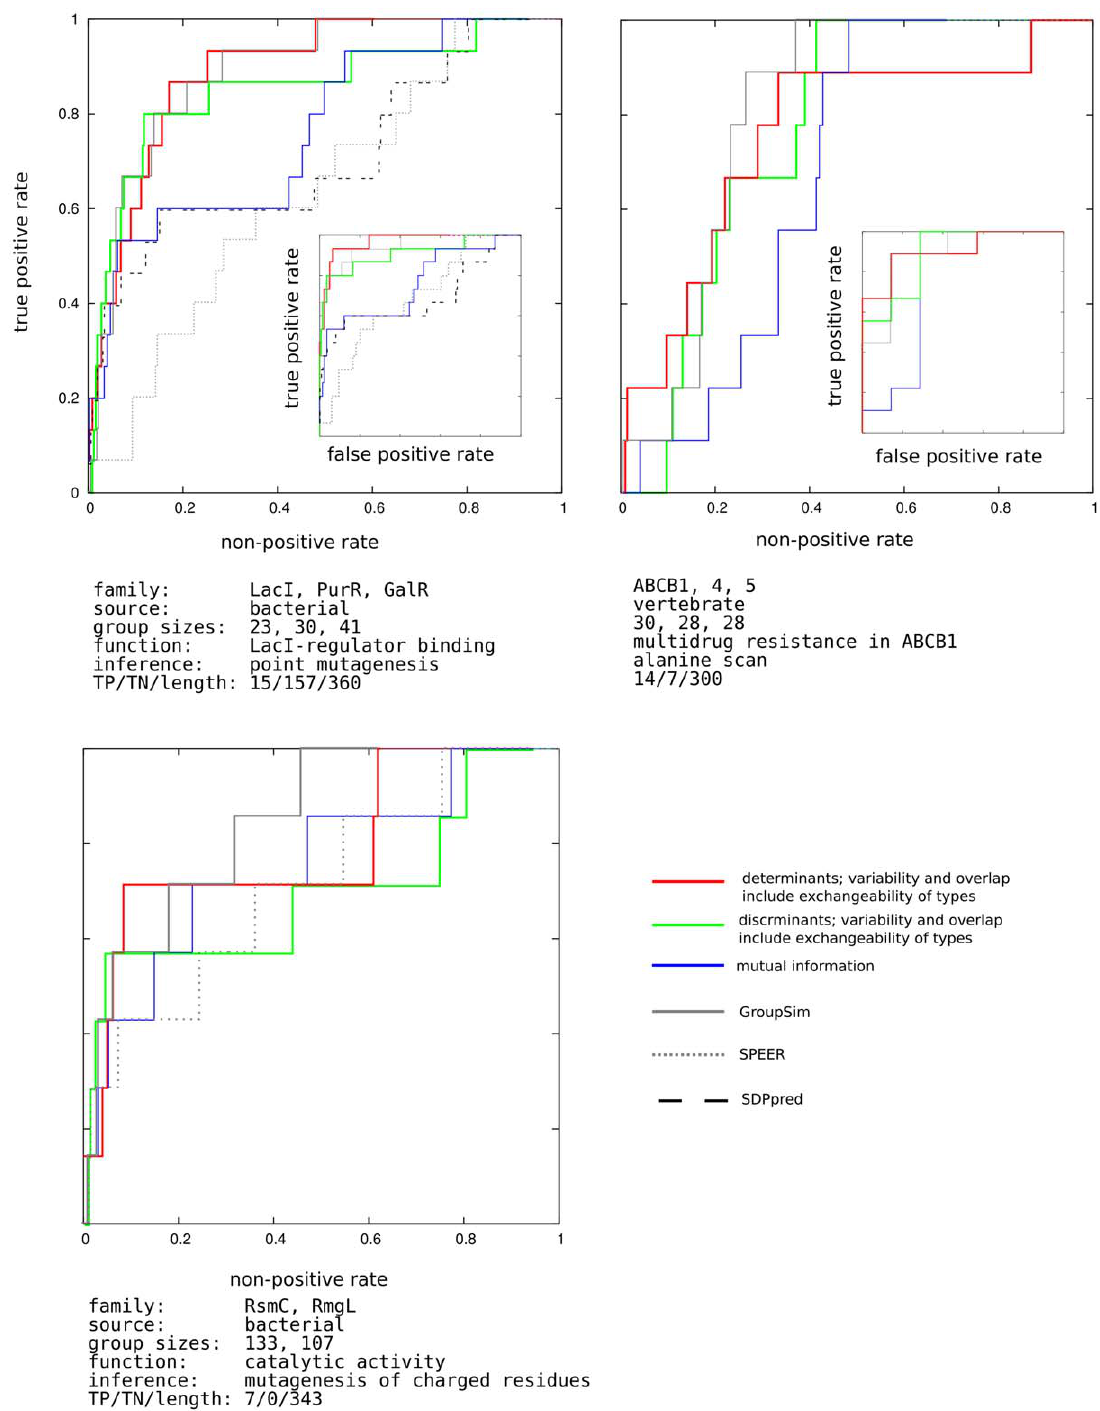
Figure 2. ROC curves for small molecule binding cases. y-axis: true positive rate - fraction of experimentally determined specific resides above threshold. x-axis: non-positive rate - fraction of residues not tested in the experiment. The residues are ordered according to a specificity scoring method. Moving the threshold down the list determines the values plotted int the graph. Inset: x-axis: true positive rate - fraction of experimentally determined specific resides above threshold. x-axis: false positive rate - fraction of residues determined experimentally to be non-specific. The methods tested are indicated in the figure legend. For each family, panel caption lists the families considered (contrasted) in the analysis, taxonomical breadth of source organisms, number of sequences in each group, function tested in the experiment, as well as the method of its inference. The resulting number of true positives (specificity determinants), true negatives, and the length of the target sequence are also listed.